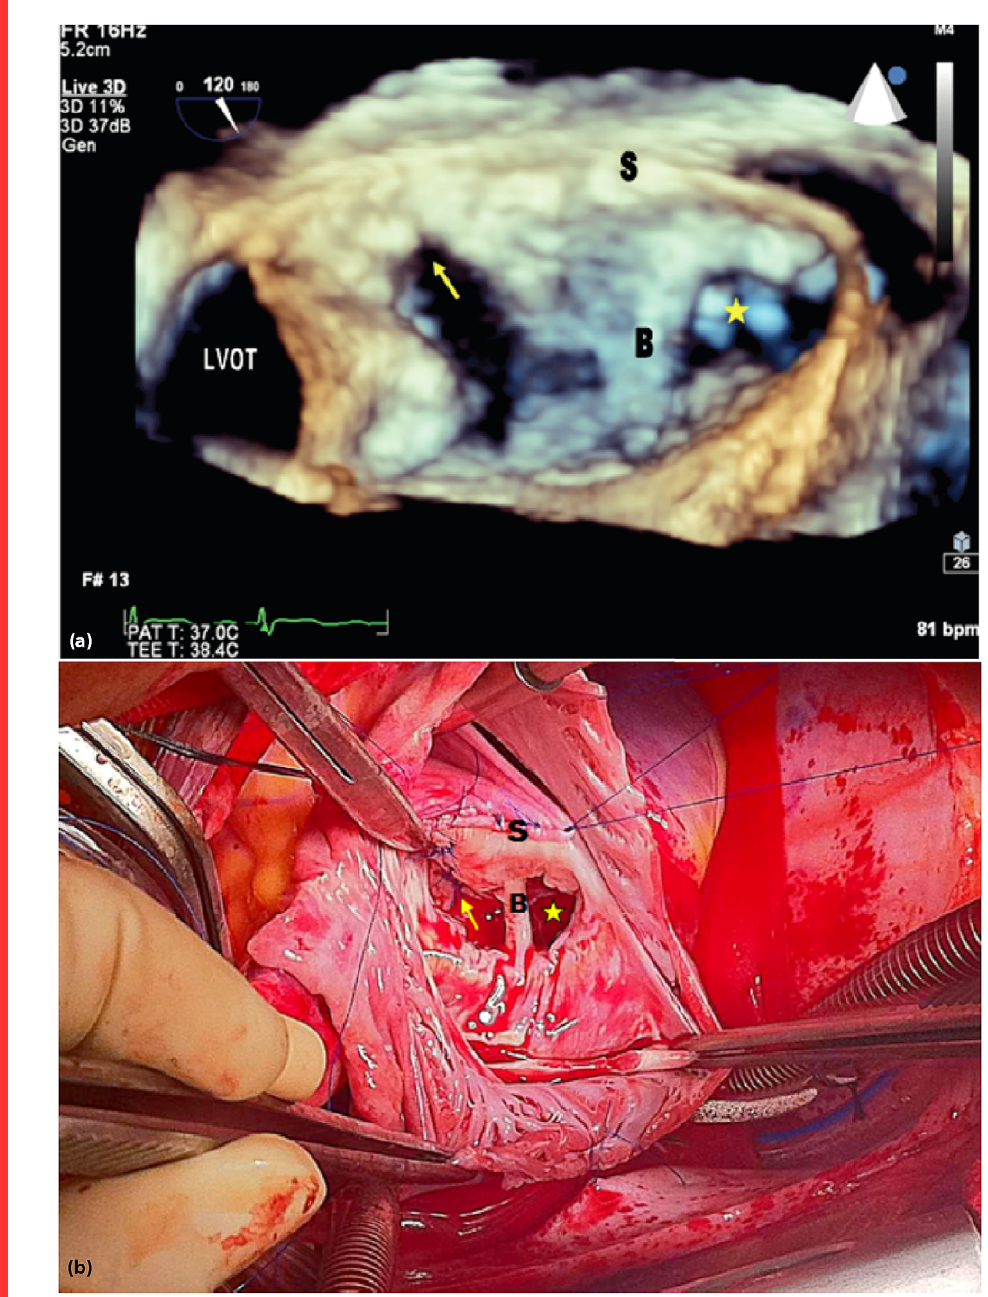
Figure. 1 (a) Three-dimensional trans-oesophageal echocardiography showing a view of the left AV valve from the left atrium. Arrow: cleft in the larger anterolateral orifice. Star: smaller posteromedial orifice. B: Bridge in between two orifices. S: Atrial septum. LVOT: Left ventricular outflow tract. (b) Surgical view of the left AV valve. Arrow: the cleft closed (in the larger anterolateral orifice). Star: smaller posteromedial orifice. B: Bridge in between two orifices. S: Atrial septum closed by a pericardial